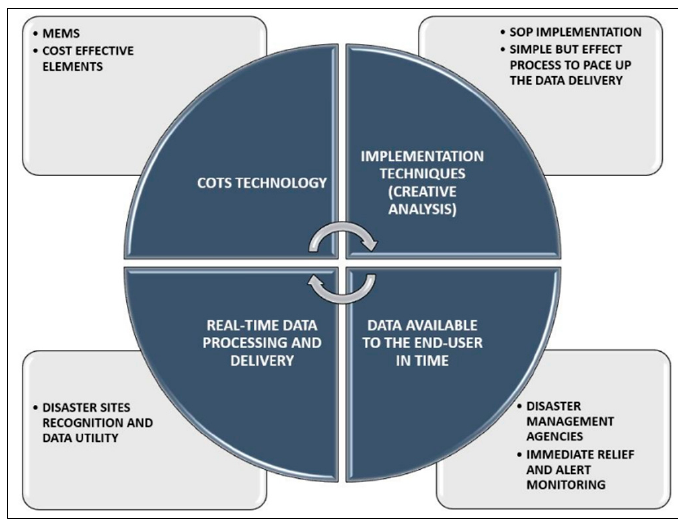
Figure 4. Disaster management implementation process.